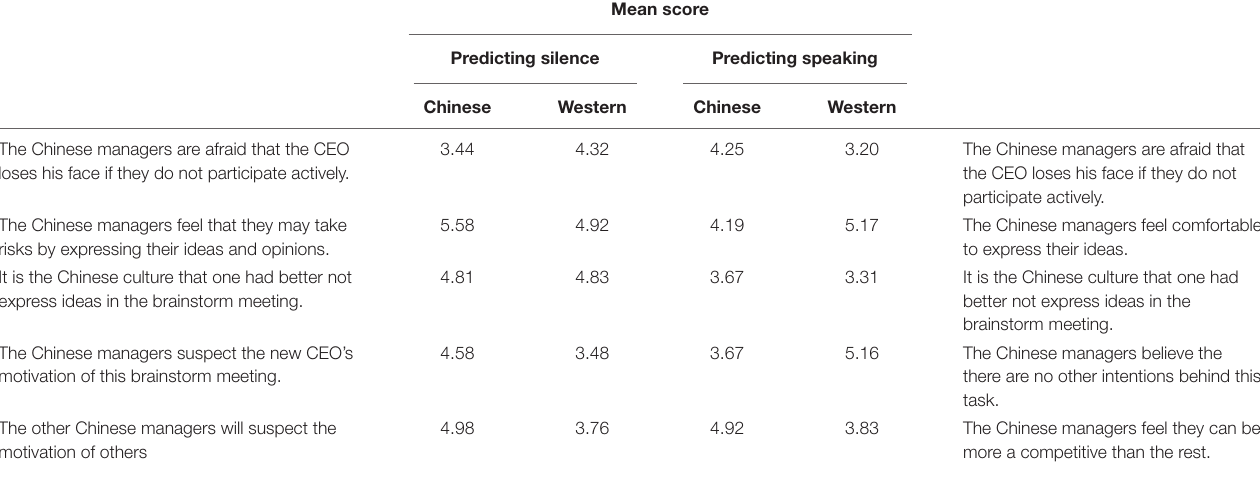
TABLE 7 | Comparison of meta-cognitive option rankings for Chinese and Western respondents by their choice of predicted course of